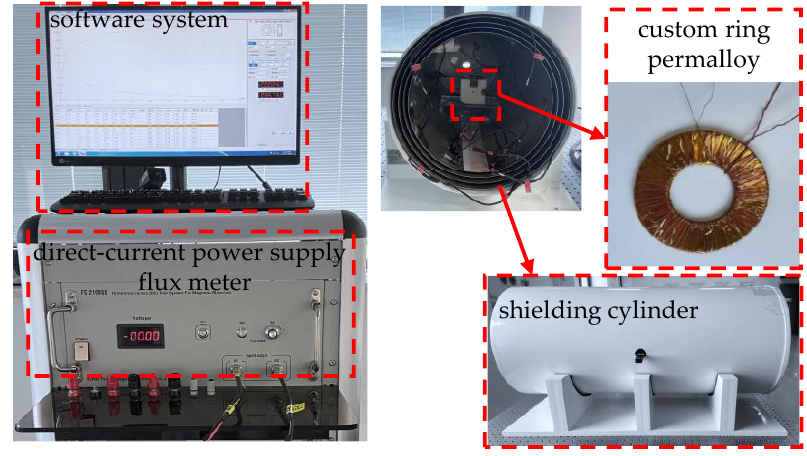
Figure 4. The outline of an extremely weak magnetic field (EWMF) test system. The measured results for the B - H curve and permeability curve of a custom large-size ring specimen in the EWMF are shown as the green dot line in Figure 5, which is consistent with the fitting curve of the Rayleigh model, as the blue solid line in Figure 5 shows. The measured minimum permeability at the H being 8 × 10 − 5 A/m (0.1 nT) is 71,876, illustrating a 0.33% difference from the permeability (72,116) obtained by the fitting function of the Rayleigh model.